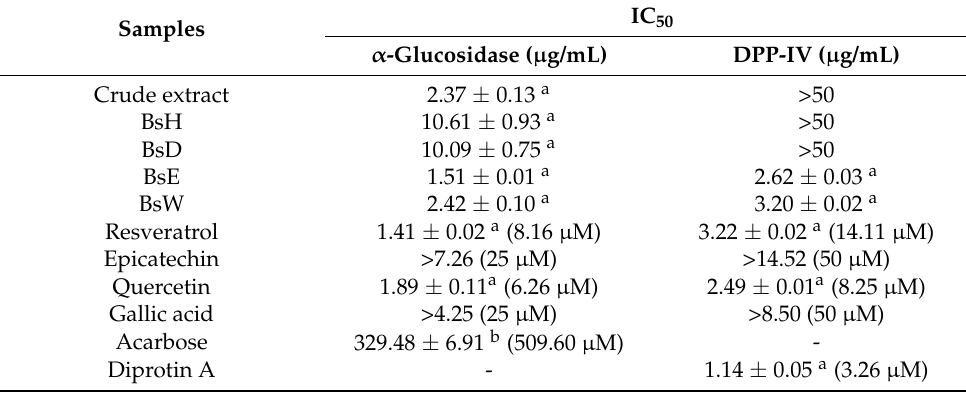
Table 3. Inhibitory activities of the crude extract, partitioned fractions, and isolated